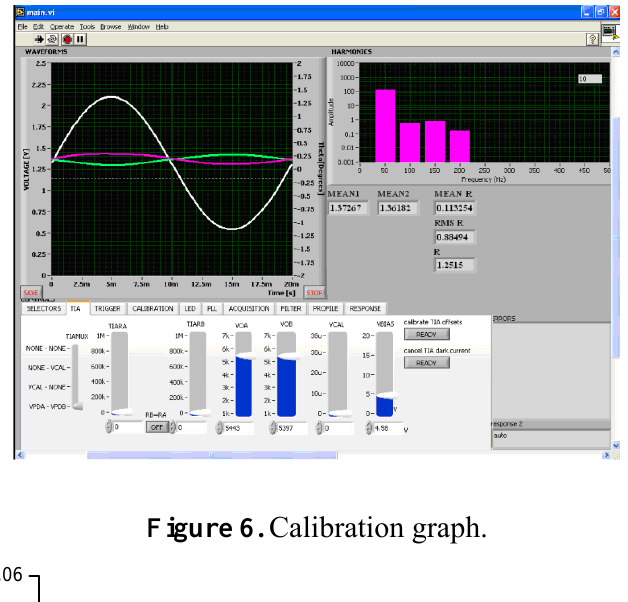
Figure 6. Calibration